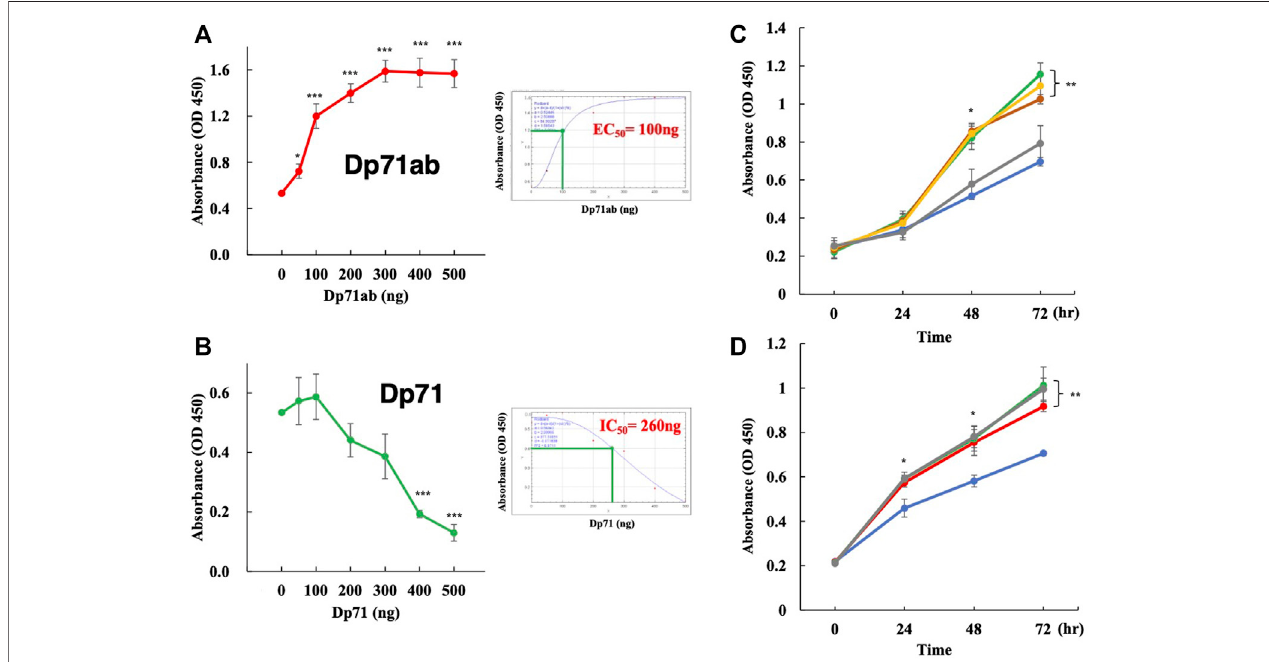
FIGURE 2 | Dp71ab, but not Dp71, enhances the proliferation of myoblasts. Myoblasts were transfected with Dp71ab and Dp71 plasmids at different doses and cultured for 72 h. Cell proliferation was assessed by the CCK-8 assay. The absorbance was determined in each well. Data are expressed as the mean ± SEM of three independent experiments. The absorbance increased linearly at doses from 0 to 300 ng of the Dp71ab plasmid (A) left. The EC 50 was calculated as 100 ng (A) right. In contrast, Dp71 decreased the absorbance linearly from 100 to 500 ng of the plasmid (B) left. The IC 50 was calculated as 260 ng (B) right. Glycine, glutamine, alanine and alpha-ketoglutarate were examined for their effect on myoblast proliferation. The addition of glycine (green), glutamine (brown) and alanine (yellow), but not alpha-ketoglutarate(gray),intheculturemediumincreasedtheabsorbancesigni fi cantlycomparedwiththatofthenontreatedcells(blue)( p < 0.05and p < 0.001after48 and 72 h, respectively) (C) . The addition of glycine to the culture medium of the Dp71ab-transfected myoblasts (gray) did not increase the absorbance compared to those in the Dp71ab-transfected (red) and glycine-supplemented (green) cells. However, all treatments increased the absorbance signi fi cantly compared to that of the nontreated cells (blue) (D) . * = p < 0.05, ** = p < 0.01, *** = p <